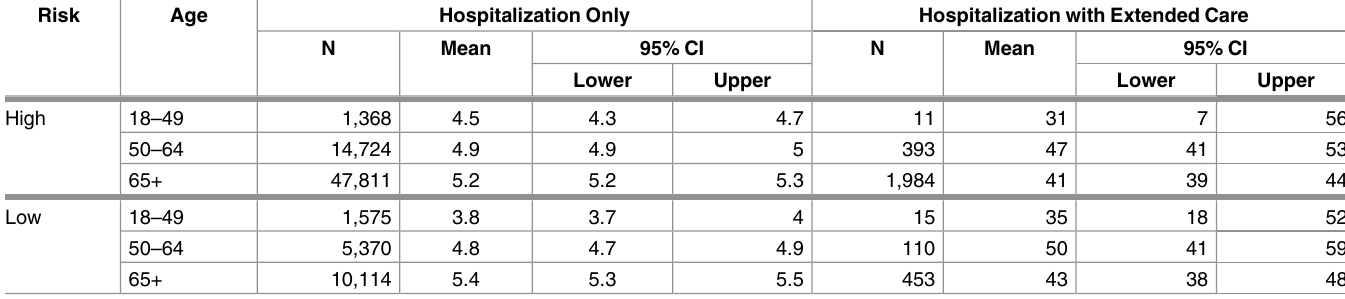
Table 7. Mean length of stay for hospitalizations without and with extended care 1 by risk and age group in days averagedover five respiratory seasons. Risk Age Hospitalization Only